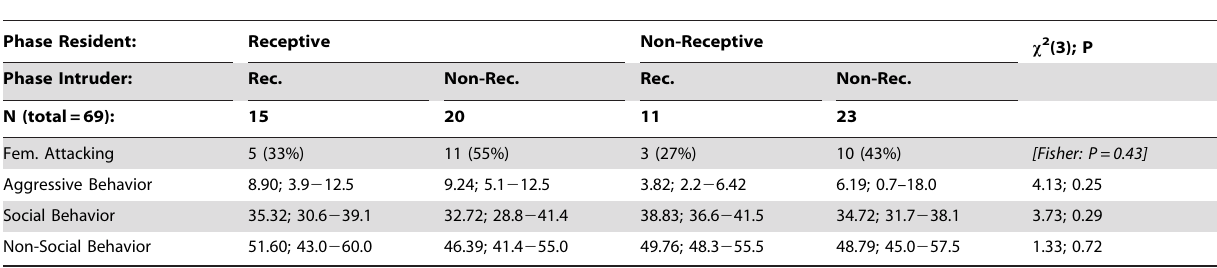
Table 1. Effect of estrous phase on behavior in the FIT.